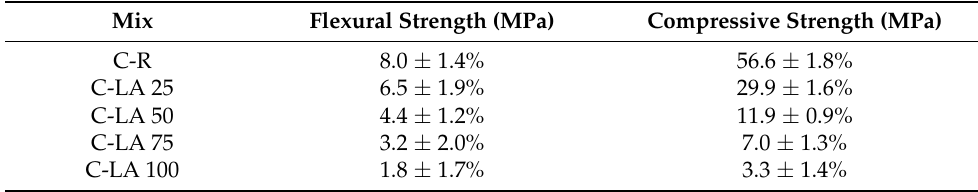
Table 5. Mechanical resistance of reference and LA dosed concretes.